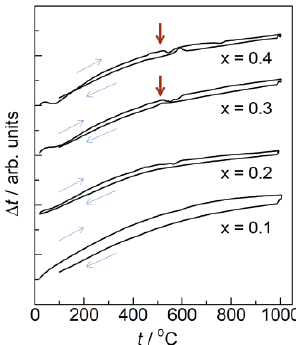
Figure 4. DTA traces of Ca 1 − x K x WO 4 − x/2 . Red arrows indicate the small endothermic peak observed in the heating direction.